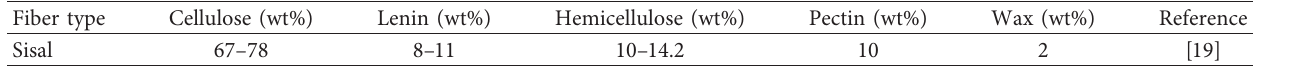
Table 1: Properties of sisal fiber and other materials.